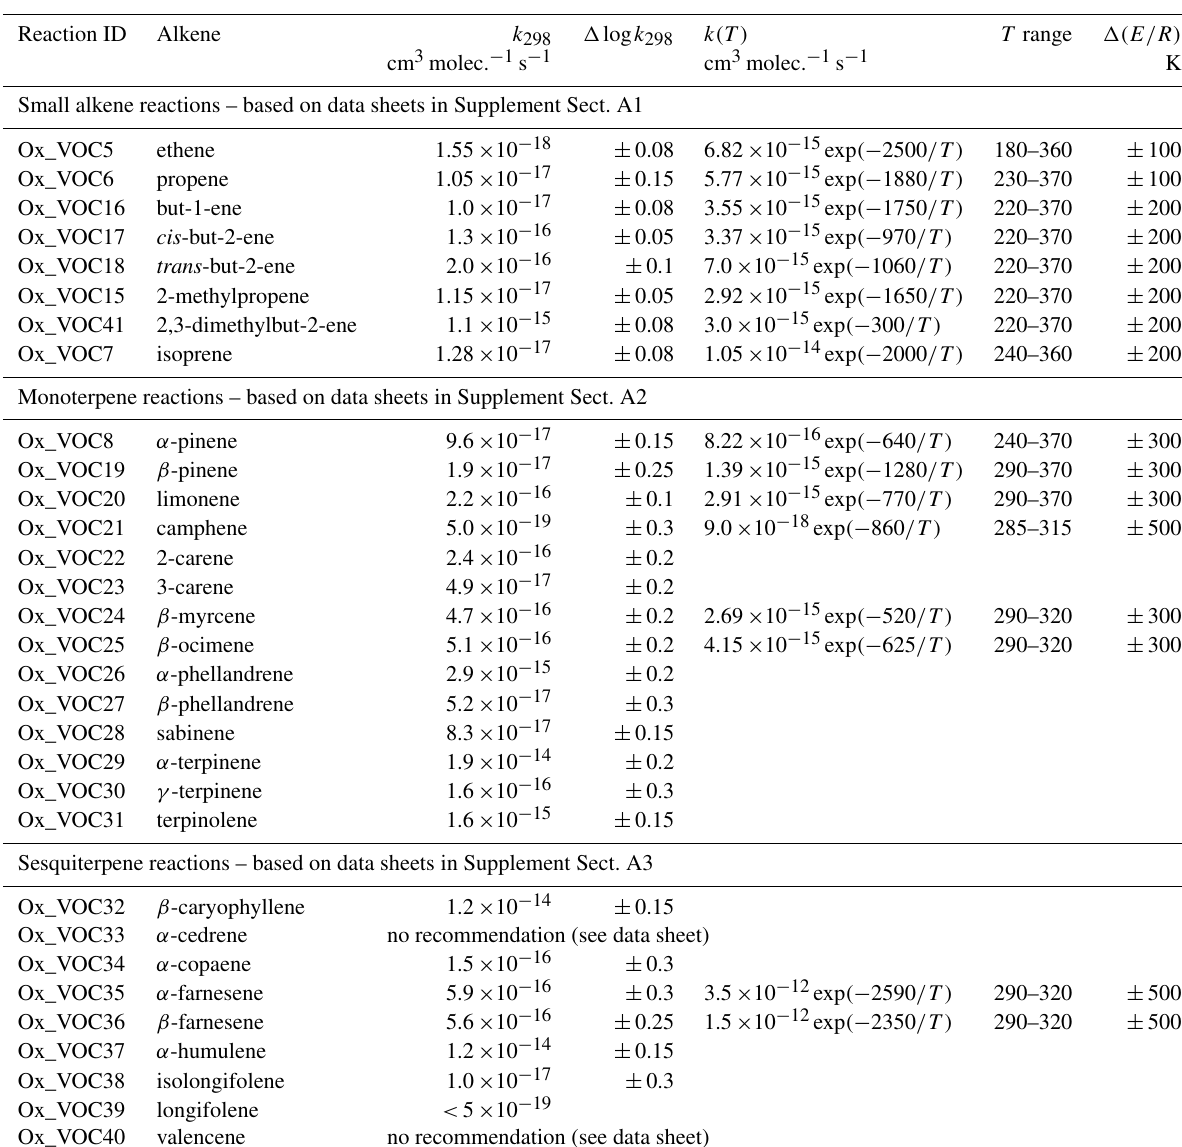
Table 1. Summary of recommended rate coefficients for reactions of O 3 with alkenes. Reaction ID Small alkene reactions – based on data sheets in Supplement Sect.